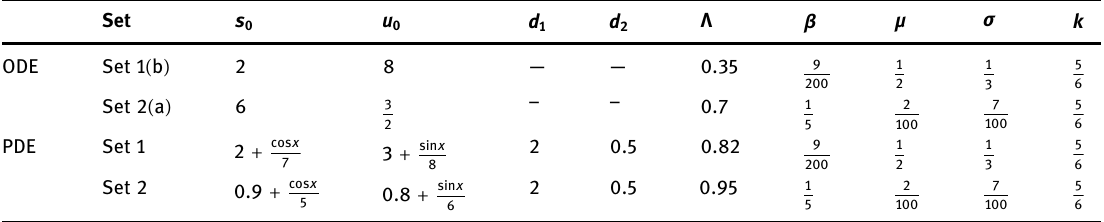
Table 1: Simulation parameters for Example